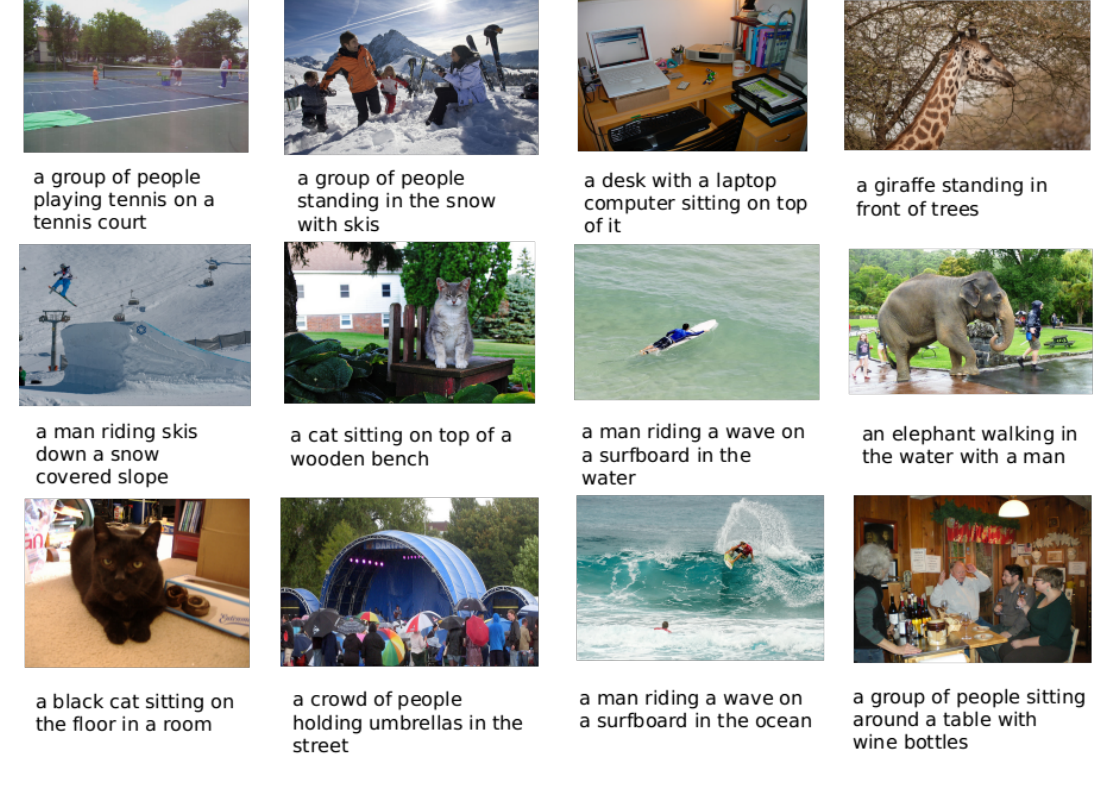
Figure 7. Example of generated